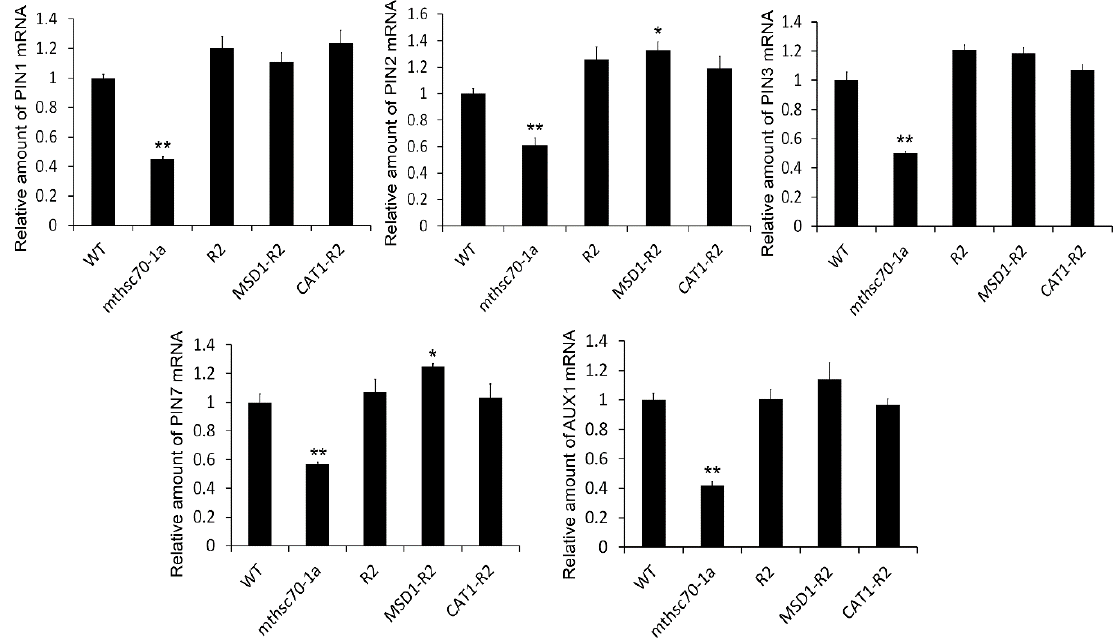
Figure 8. Introduction of the mtHSC70-1 , MSD1 or CAT1 gene into mthsc70-1a rescued the expressions of auxin transport carrier genes in roots. Transcripts of PIN1 , PIN2 , PIN3 , PIN7 and AUX1 genes in roots of 10 days old WT, mthsc70-1a , R2, MSD1-R2 and CAT1-R2 seedlings were analyzed by Q-PCR using gene-specific primers (Table S1). The data are shown as the means ± SD of three biological replicates. The asterisks indicate significant differences from the WT ( t- test, *, p < 0.05; **, p < 0.01). WT, wild-type; mthsc70-1a , a mtHSC70-1 mutant line; R2, a mthsc70-1a / mtHSC70-1:mtHSC70-1 line; MSD1-R2, a mthsc70-1a / mtHSC70-1:MSD1 line; CAT1-R2, a mthsc70-1a / mtHSC70-1:CAT1